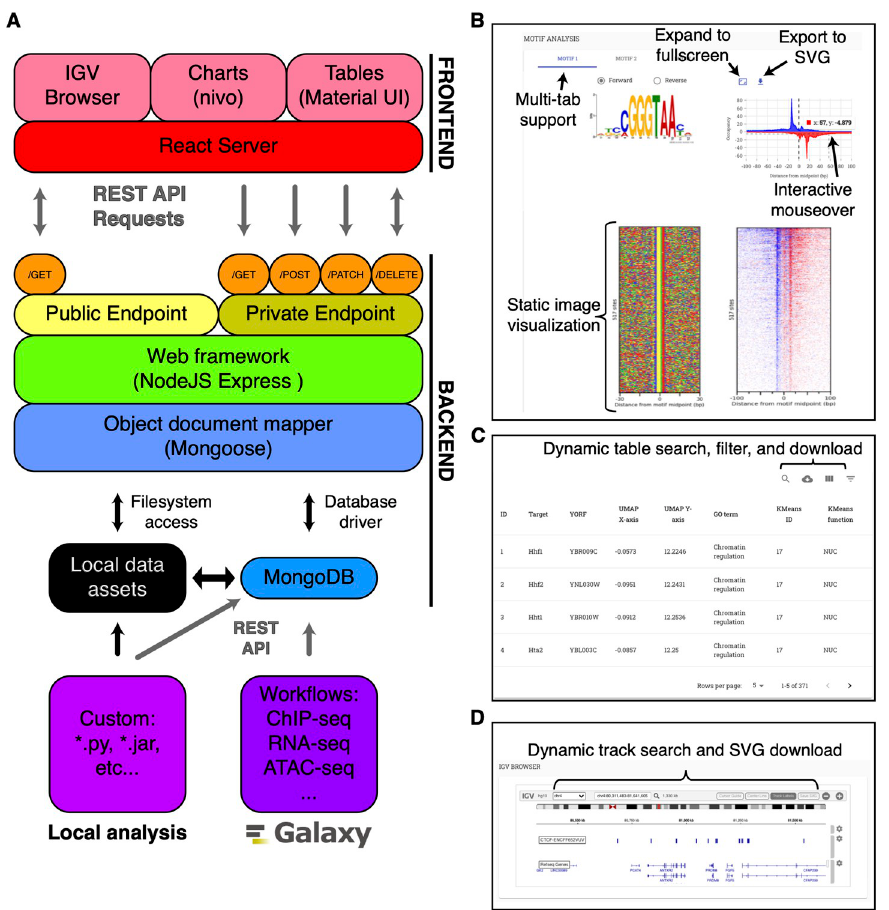
Fig 1. Overview of STENCIL architecture. (A) A ReactJS frontend server provides web-access to the data. A NodeJS server and MongoDB instance store and manage the data provided and disseminated through RESTful API calls. Data analysis and hosted URLs are provided by the Galaxy platform and communicated directly to the MongoDB. Local analysis and file-hosting outside of the Galaxy platform is also supported. (B) A sample React-served experiment section demonstrating multiple types of data. React serves static PNG/JPG/SVG images hosted remotely. Interactive charts include dynamic mouseover with additional data, the ability to expand to full screen, and export to SVG. (C) Data table analysis allows for sorting and filtering using remotely hosted data. (D) Integrated Genome Browser (igv) provides interactive track visualization in the same web frame as other advanced analysis.